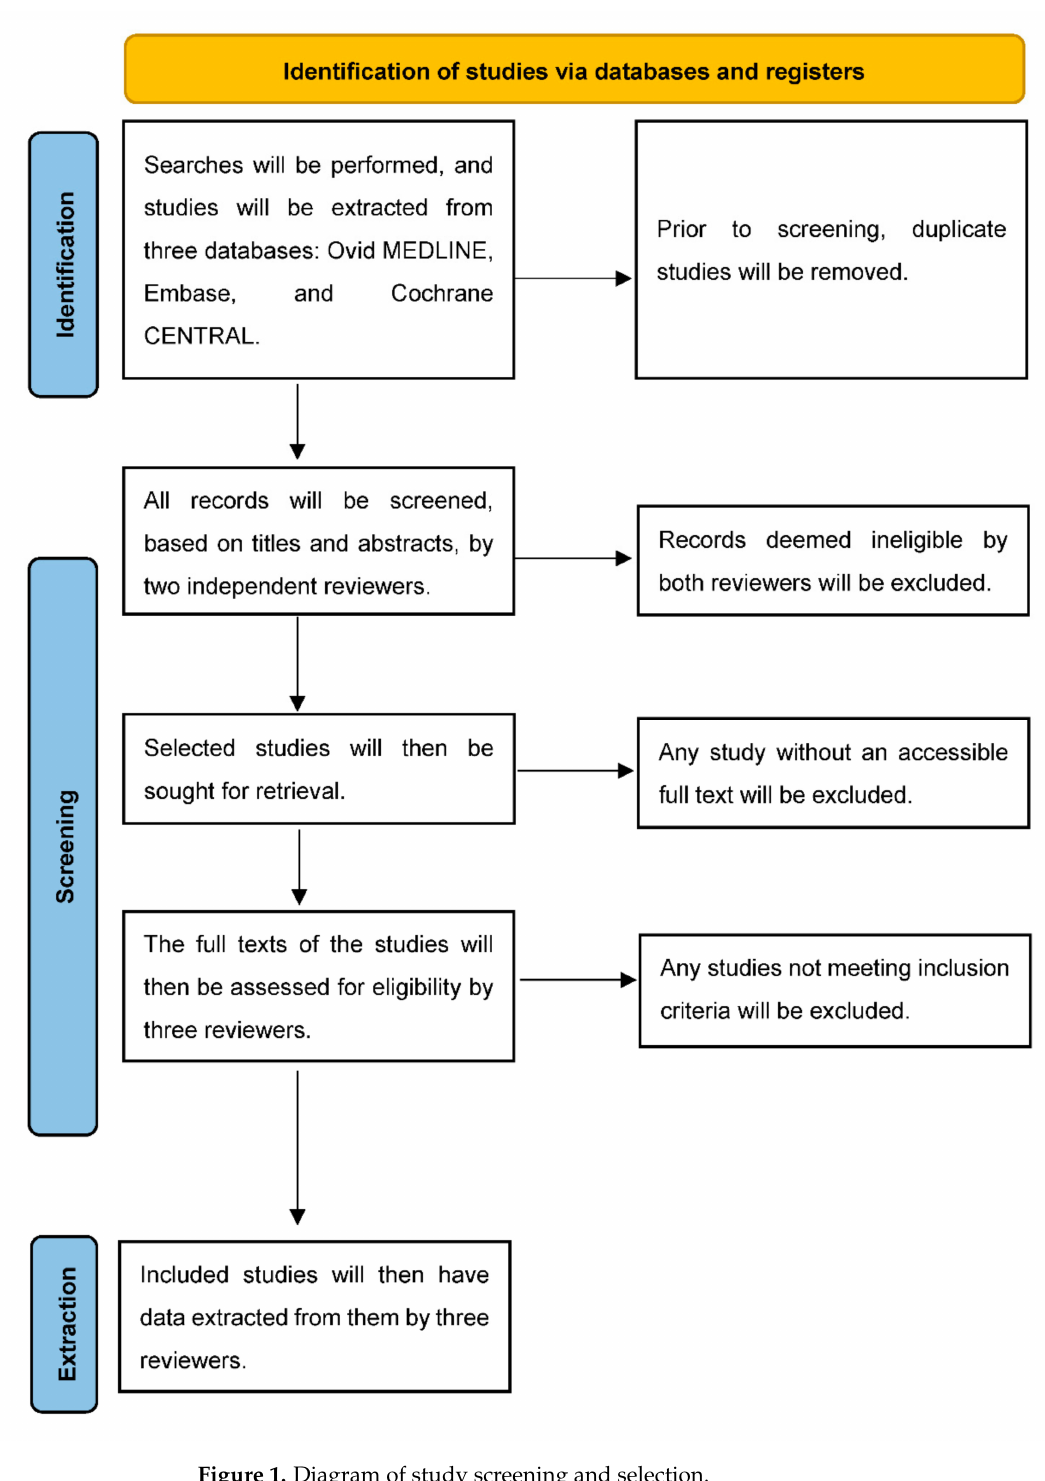
Figure 1. Diagram of study screening and